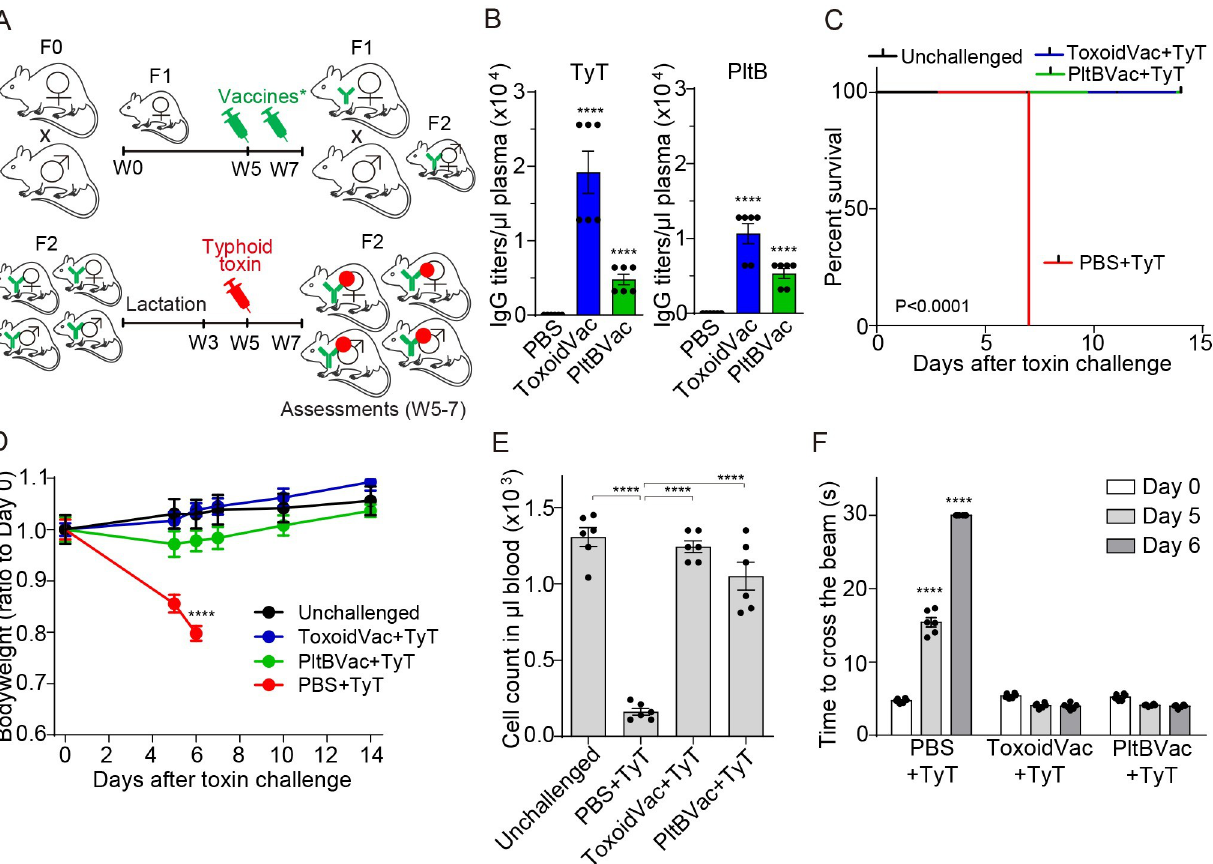
Fig 1. Maternal antibodies protected their progenies from a lethal-dose typhoid toxin challenge. A , Schematic cartoon describing the timelines for maternal vaccinations, 2 μ g typhoid toxin challenge, and assessments for protection. F1 mothers received two doses (2 μ g each) of inactive typhoid toxoid (ToxoidVac) or PltB pentamer (PltBVac) at weeks 5 and 7 (W5 and W7). The vaccinated F1 female mice were mated with unvaccinated F1 male mice, resulting in F2 progenies. Five-week-old F2 mice were challenged with a lethal-dose active typhoid toxin and evaluated for survival, body weight changes, peripheral immune cell counts, and upper motor functions. B , Titers of maternal antibodies specific to typhoid toxin (TyT) and PltB pentamer (PltB) available in 1 μ l of the indicated F2 mouse plasma collected at week 5. Standard end-point titration methods were used. PBS (black bars), F2 mice from F1 mothers received PBS. ToxoidVac (blue bars), F2 mice maternally vaccinated with ToxoidVac. PltBVac (green bars), F2 mice maternally vaccinated with PltBVac. C , Percent survival of the maternally-vaccinated F2 mice challenged with 2 μ g typhoid toxin (TyT). D , Body weight changes of these F2 mice. E , Circulating neutrophil counts in mouse peripheral blood on day 6 after the typhoid toxin challenge. F , Balance beam walking results of these F2 mice on days 0, 5, and 6 after typhoid toxin challenge. Bars represent the mean values of two independent experiments ± standard error of the mean (SEM). The total of n = 6 per group. ���� , p < 0.0001, relative to the PBS group for B, to the unchallenged group for D, to the unchallenged group or the TyT group for E as indicated in the graph, and to the day 0 value for F. The log-rank test was performed for C and two-tailed unpaired t-tests for B, D, E, and F.